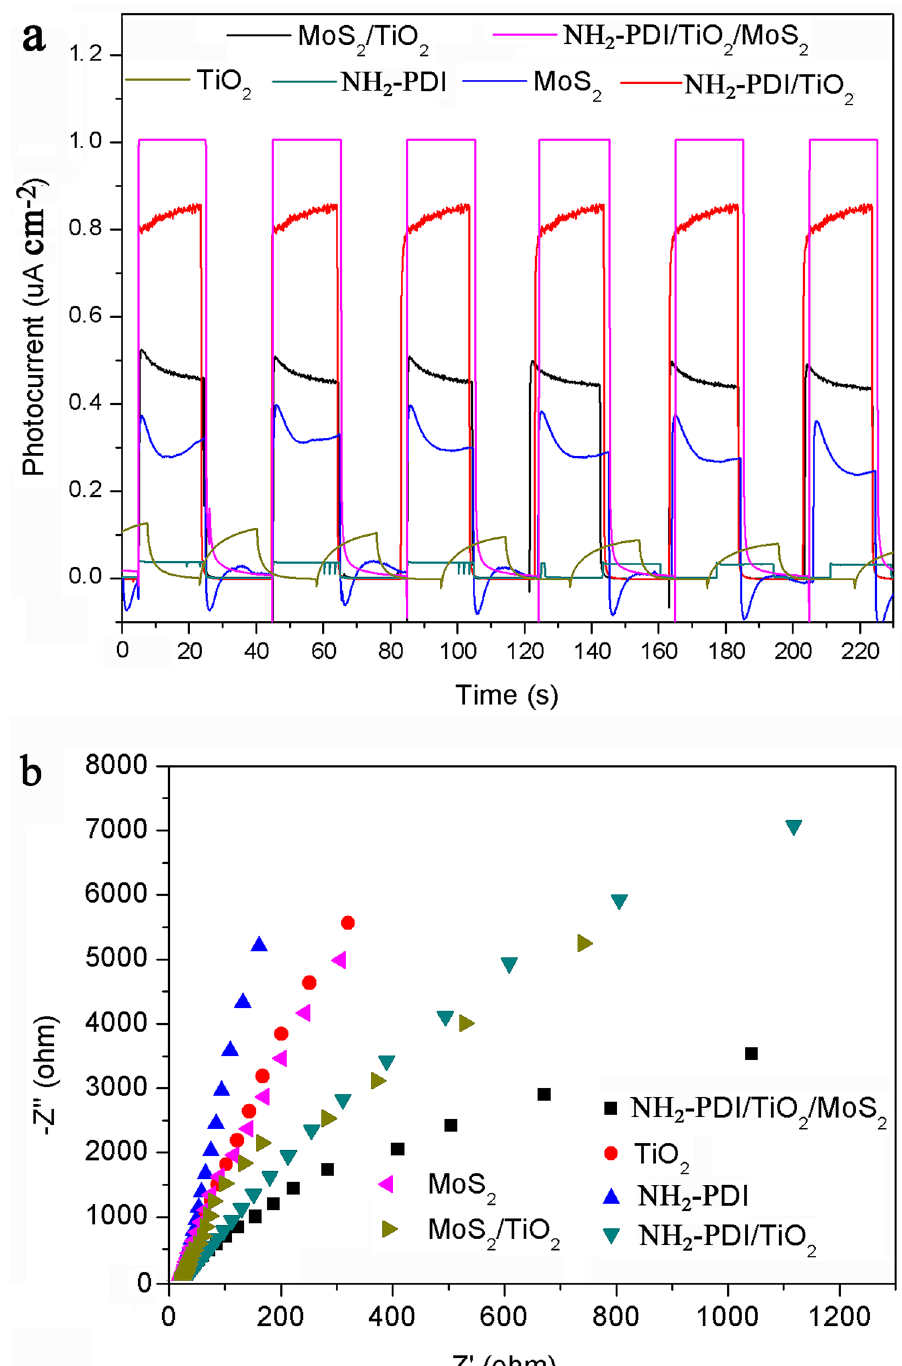
Figure 8. ( a ) Photocurrent transient responses and ( b ) EIS spectra of TiO 2 , NH 2 -PDI, NH 2 -PDI/TiO 2 , MoS 2 , MoS 2 /TiO 2 , and NH 2 -PDI/TiO 2 /MoS 2 at a constant potential of 0.4 V with simulated solar light at 300 mW/cm 2 . frequency: 0–10,000 Hz, electrolyte: 0.1 M Na 2 SO 4 , amplitude: 10